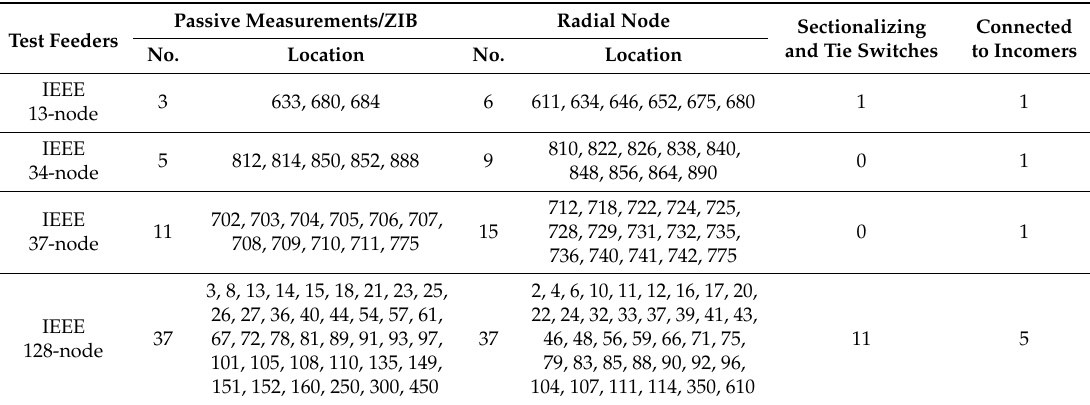
Table 1. The IEEE standard distribution test feeders’ specifications